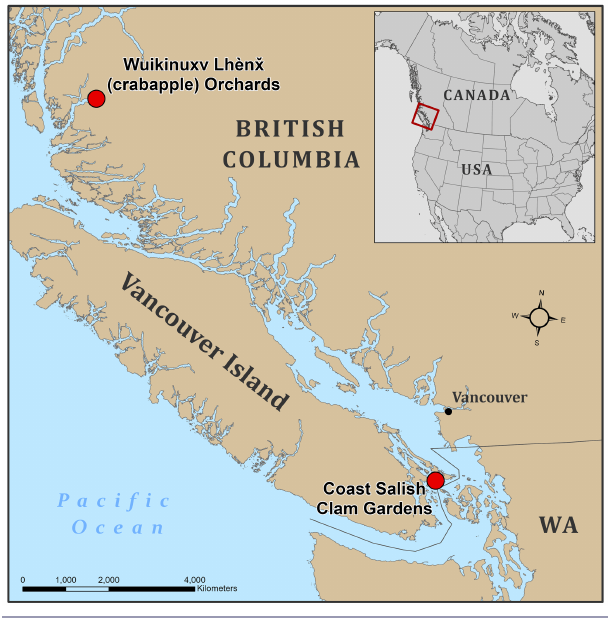
Fig. 2. Map of coastal British Columbia showing the approximate location of the Lhe ̀ nx ̌ (crabapple) orchards in Wuikinuxv territories and the clam gardens in the Gulf Islands National Park Reserve located in Coast Salish territories. Map courtesy of the Hakai